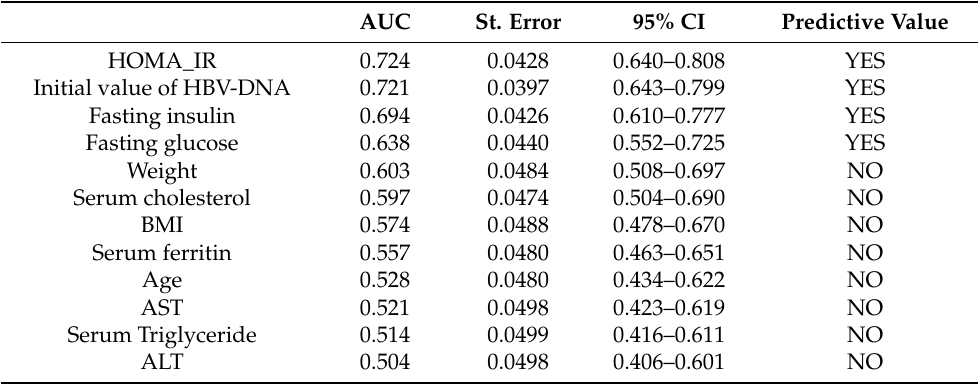
Table 7. The interpretation of the lot through AUC